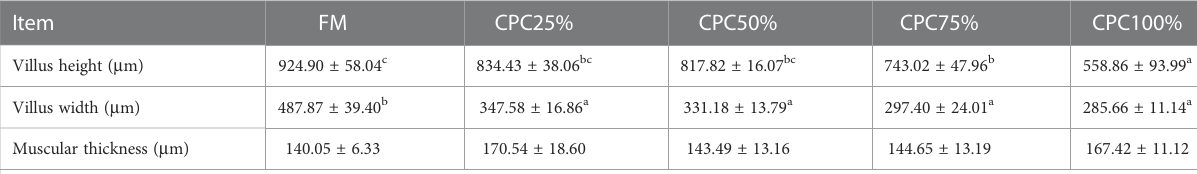
TABLE 9 Effects of fi shmeal replacement by cottonseed protein concentrate on histology of distal intestine in rainbow trout (Mean ± S.E.). Item